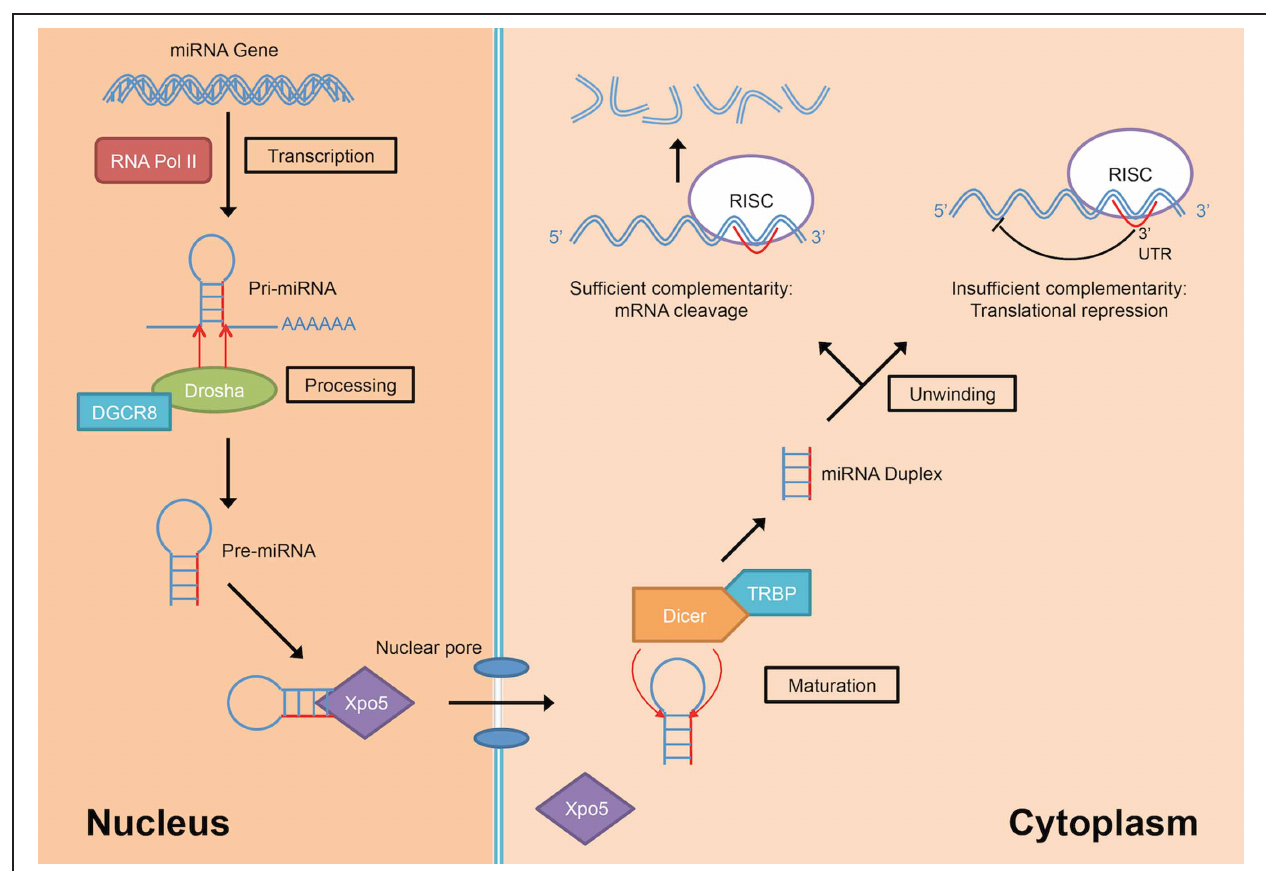
FIGURE 3 | MiRNA biogenesis and mode of action (DGCR8, DiGeorge Critical Region 8; RISC, RNA-induced silencing complex; RNA Pol II, RNA polymerase II; TRBP, Tar-RNA binding protein; Xpo5, Exportin-5).